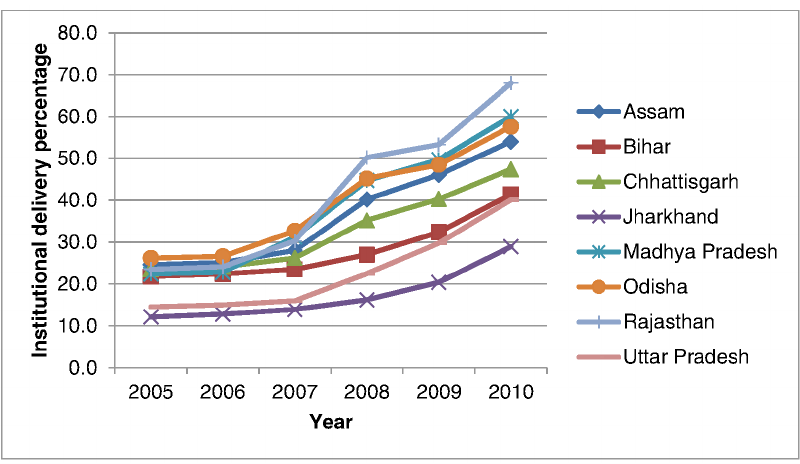
Figure.2. Trends in institutional births.